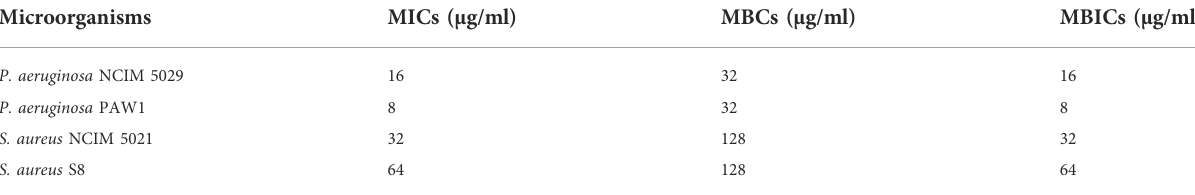
TABLE 1 Antibacterial and antibio fi lm activity of CAAgNPs against MDR/XDR pathogens. Microorganisms MICs